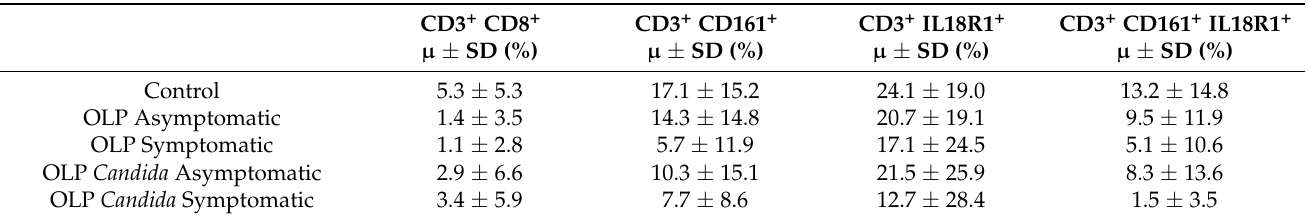
Table 2. Mean and standard deviation of T cell phenotypes as a percentage of the total CD3 population for the 5 groups presented using the raw data.